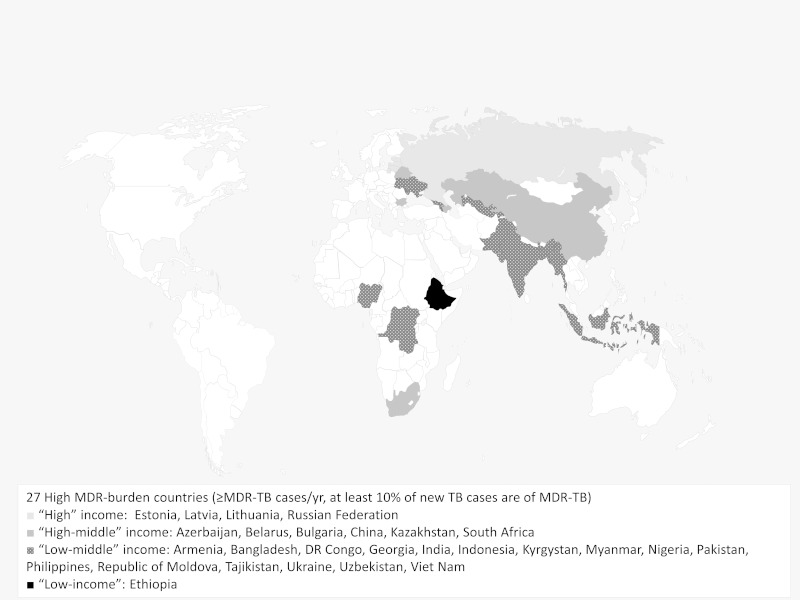
High-burden multidrug-resistant TB (MDR-TB) countries by income status. According to the World Bank, low-income economies are defined as those with an annual Gross National Income (GNI) per capita of <US$1045, low–middle income economics have a GNI per capita of US$1045–4125, high-middle income economies have a GNI per capita of US$4125–12 746 and high-income economies have a GNI per capita of >US$12 746.